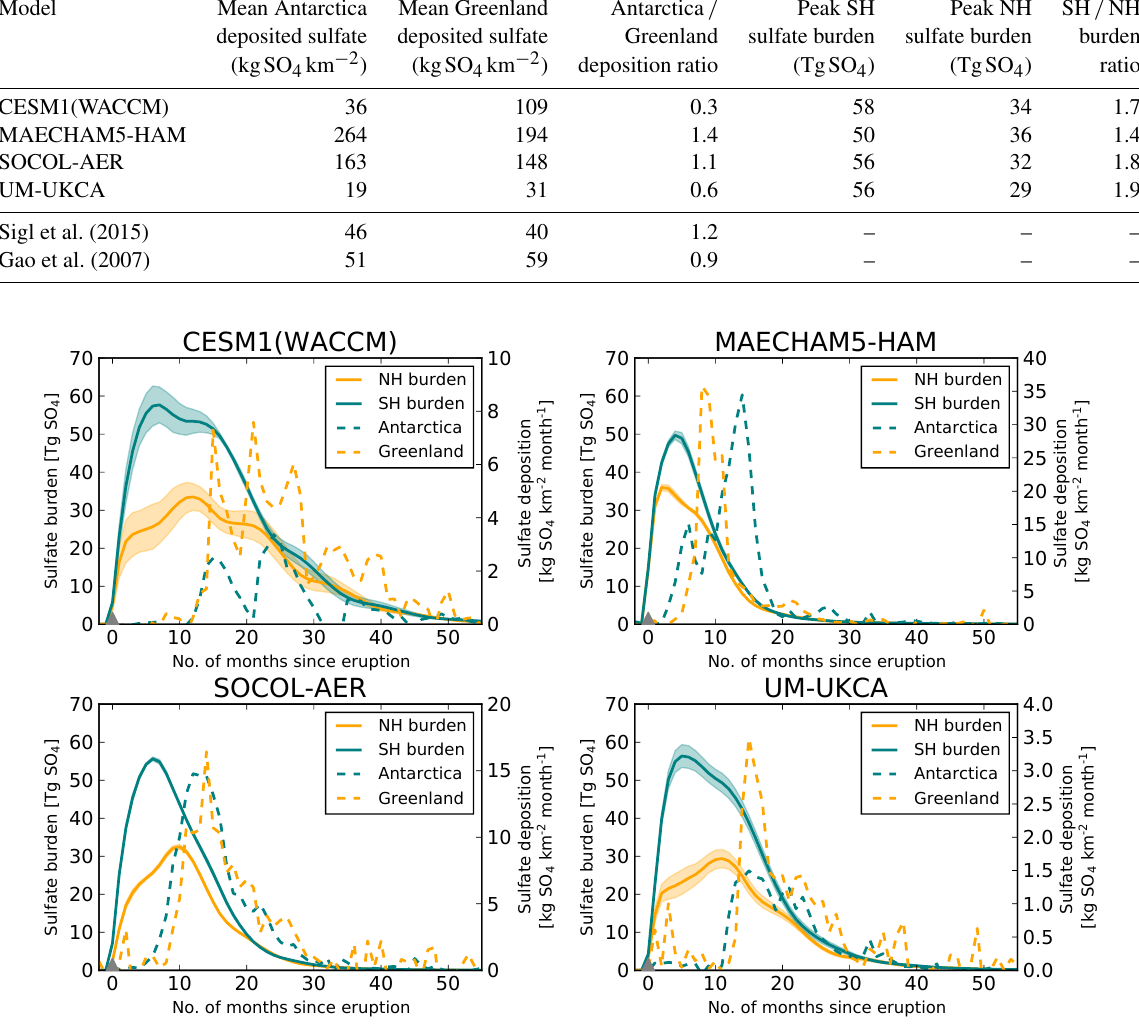
Figure 11. Hemispheric atmospheric sulfate burdens (TgSO 4 ) (solid lines show the ensemble mean and shading is 1 SD) and area-mean ice sheet volcanic sulfate deposition as in Fig. 9 (dashed lines) (kgSO 4 km − 2 month − 1 ) for each model. The grey triangles mark the start of the eruption (1 April 1815). There are different scales on each secondary y axis for ice sheet